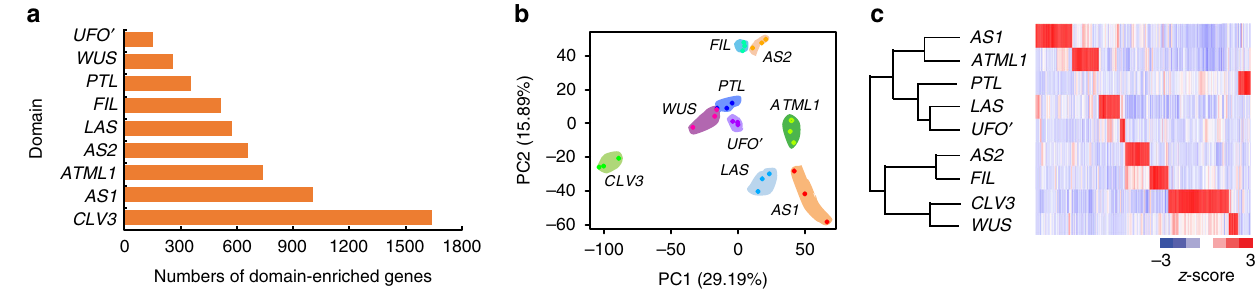
Fig. 2 Domain-speci fi c expression patterns. a Number of domain-enriched genes in each domain. b Principal component analysis of the nine domains with triple biological repeats for each type. c Hierarchical clustering analysis of domain-enriched genes. Complete linkage hierarchical clustering was performed on relative expression ( z -score) as described in